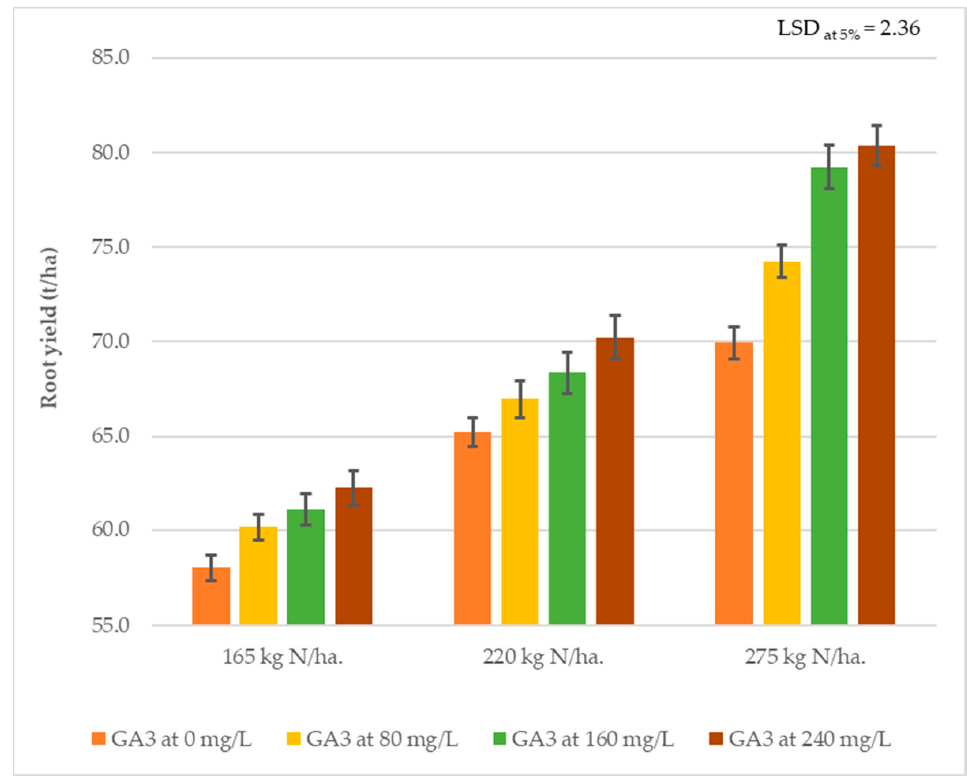
Figure 2. Root yield (t/ha) as affected by the interaction between nitrogen fertilizer levels and GA 3 spraying concentrations in the first season (2014/2015).